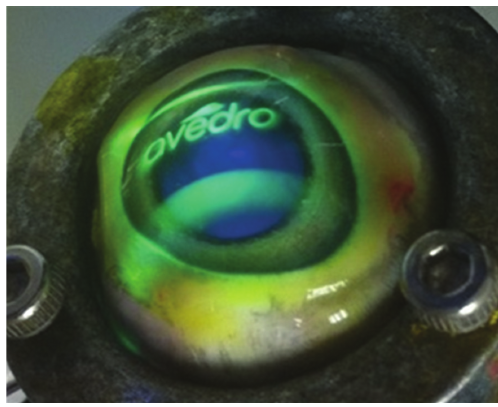
Figure 2: Example of the flexibility of UV source patterns projected on an excised porcine